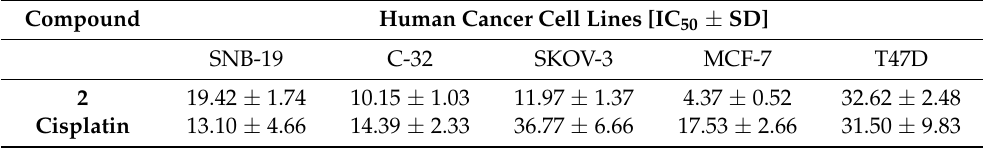
Table 1. Cytotoxic activity of 1,2,3-triazole derivative 2 and cisplatin against SNB-19,C-32, SKOV-3, MCF-7, and T47D cells (IC 50 in µ